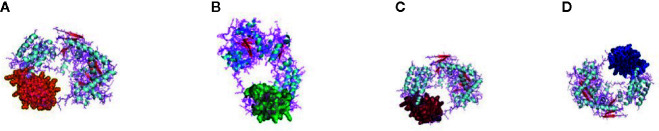

(A) RLR_C-terminal domain of the gene of sheep. (B) RLR_C_like domain of RIG gene of sheep. (C) LGP2_C, C-terminal domain of Laboratory of Genetics and Physiology 2 (LGP2) of sheep. (D) MDA5_C, C-terminal domain of melanoma differentiation-associated protein 5 of sheep.